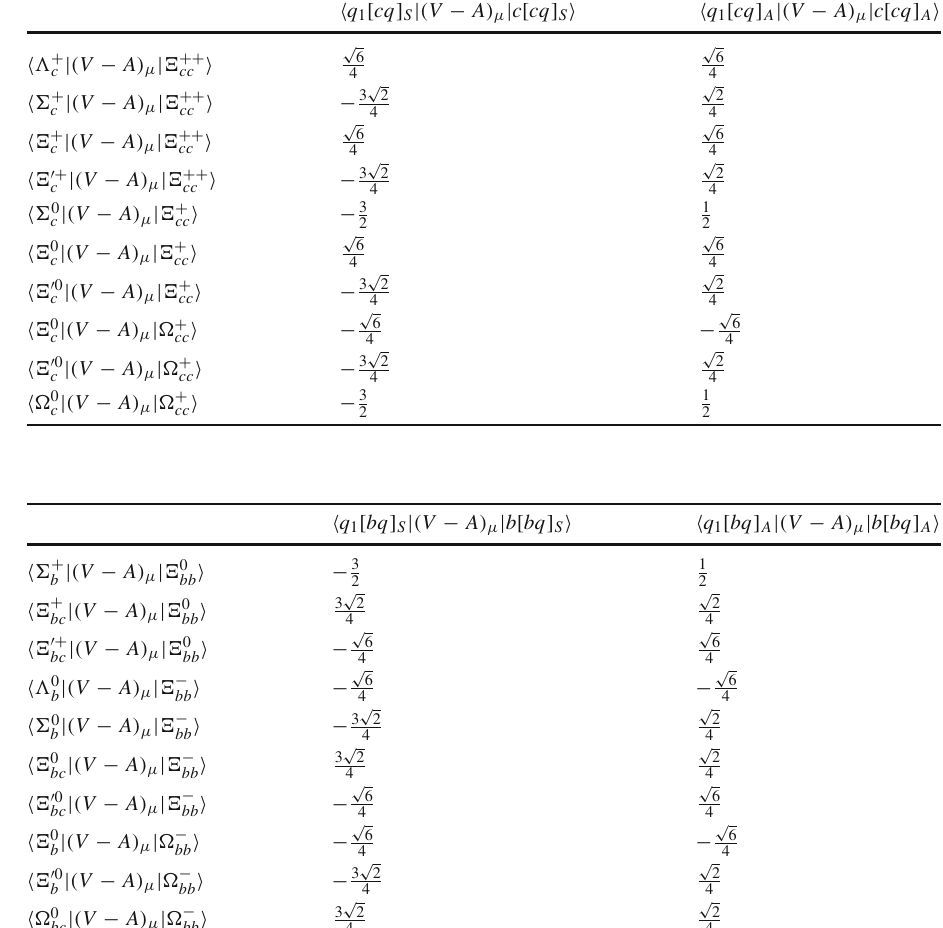
the transition matrix elements for the doubly charmed baryon decays. Taking the (cid:4) ++ cc → (cid:2) + c